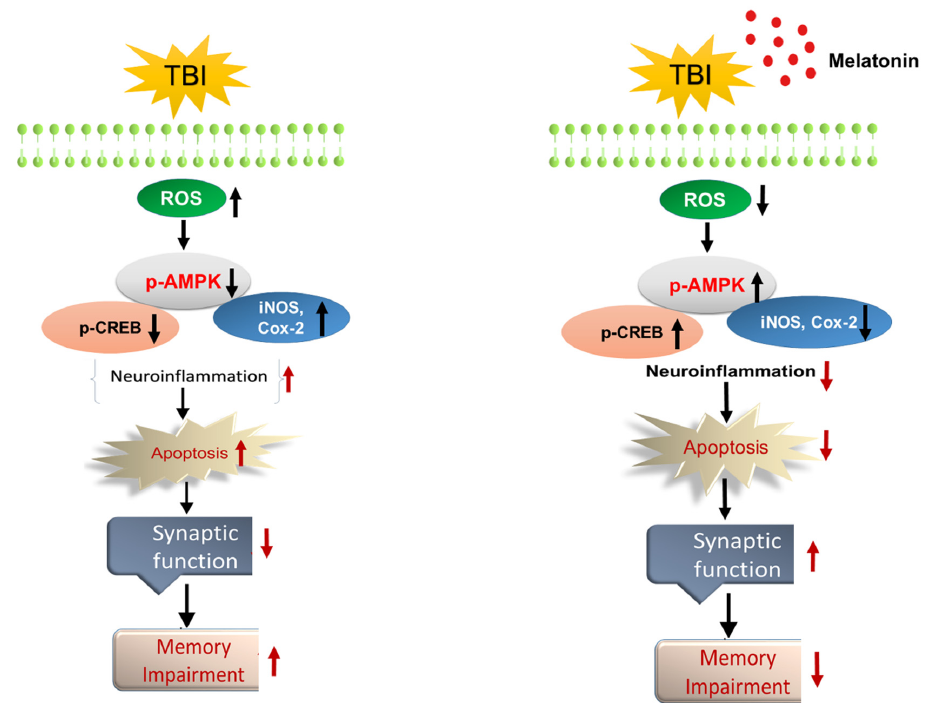
Figure 9. The schematic diagram represents the mechanism of melatonin neuroprotection in mouse brains following traumatic brain injury (TBI). The schematic representation showing that melatonin treatment for 7 days reduced oxidative stress and the AMP-activated protein kinase / CAMP-response element-binding (AMPK / CREB) level, inhibited neuroinflammation and neuronal apoptosis, and improved memory functions via regulation of the AMPK / CREB signaling pathway after